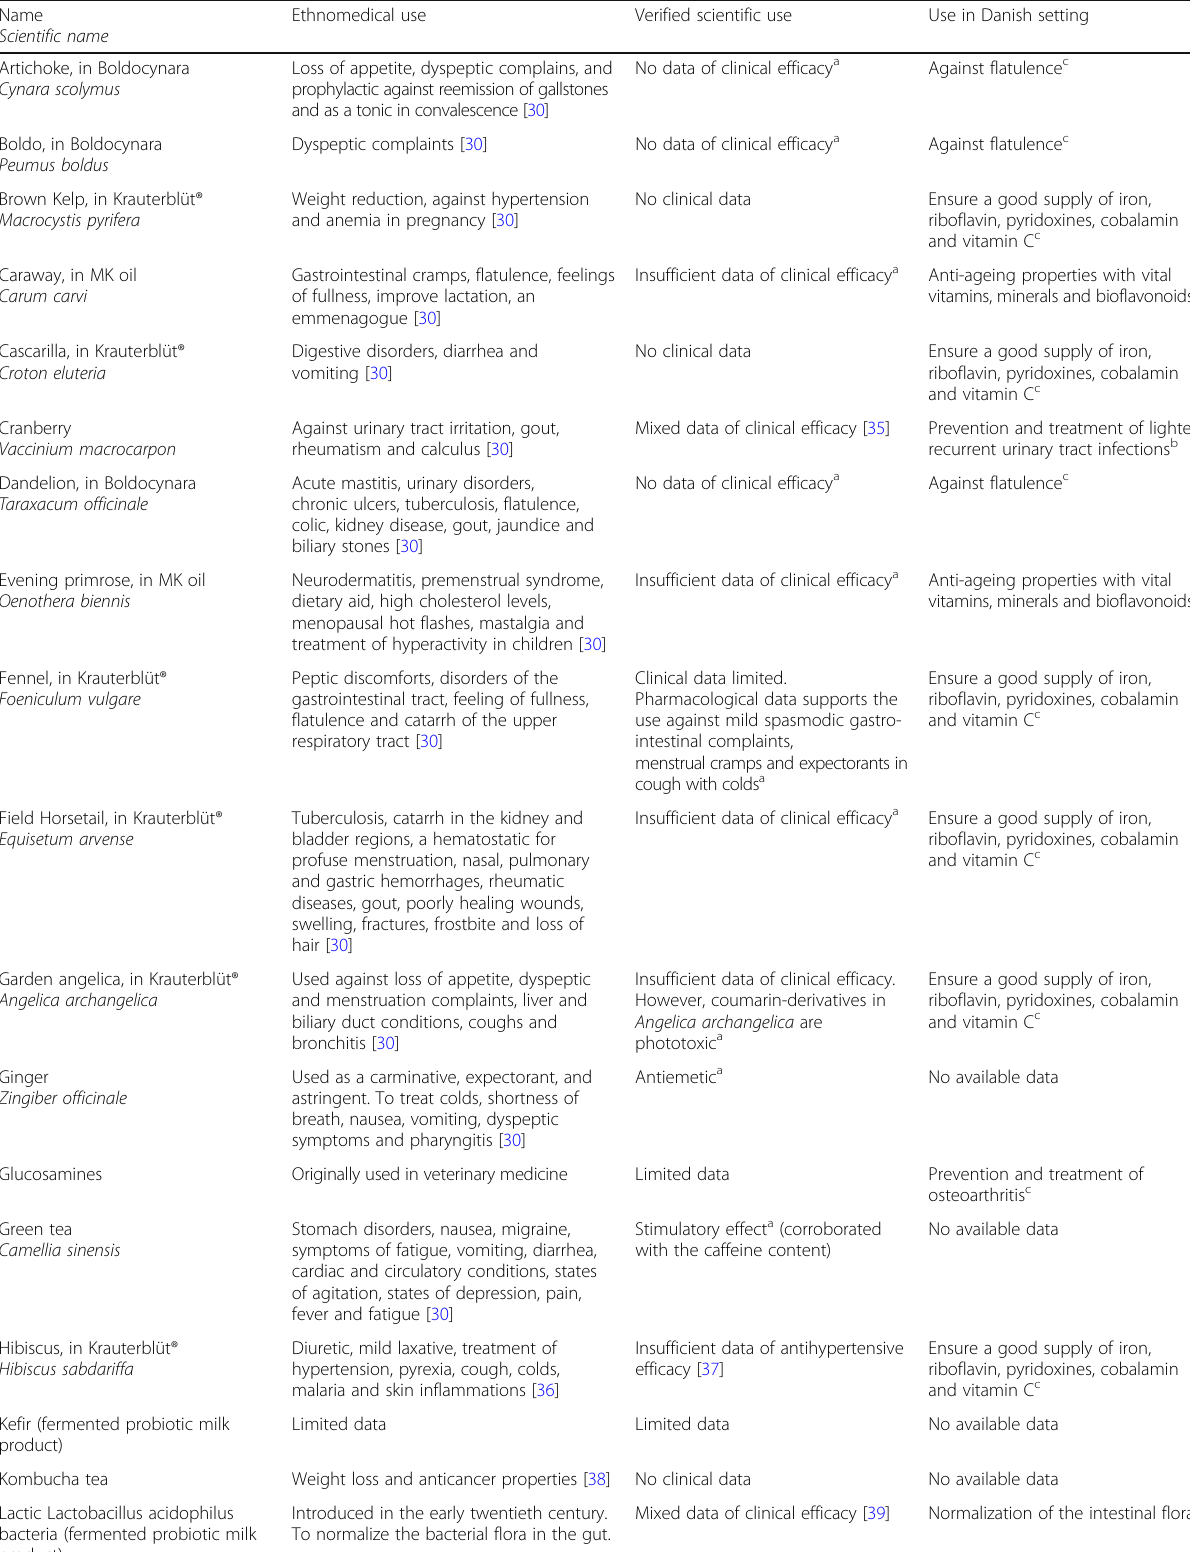
Table 4 Usages of alternative medicines Name Scientific